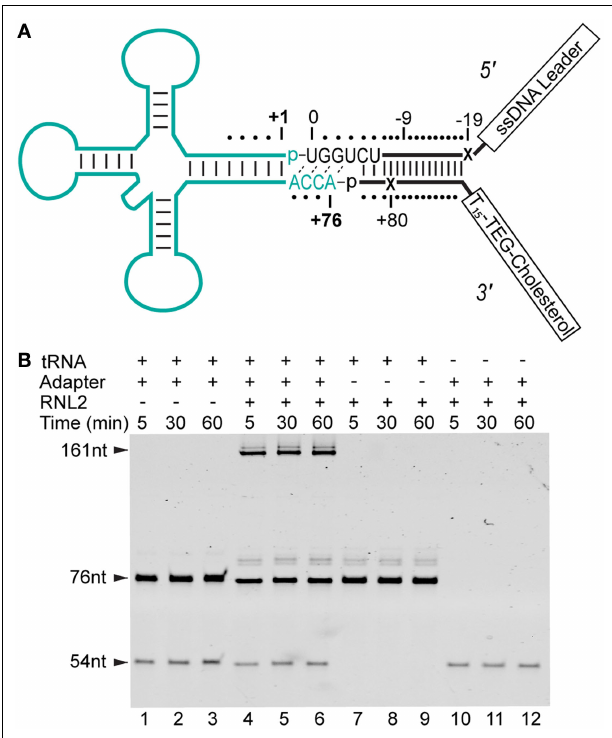
FIGURE 1 | Strategy for constructing adapter-linked tRNA molecules for nanopore experiments . (A) The DNA/RNA chimeric adapter (black lines; RNA nucleotides black letters) was composed of a double stranded region and a four nucleotide RNA overhang (UGGU) ligated to the tRNA (cyan). The adapter specifically targets the conserved CCA tail of deacylated, native tRNA. Phosphodiester bonds formed by enzymatic ligation between the tRNA and the adapter are indicated by dashes between the 3 ′ terminal nucleotide and 5 ′ phosphate (p) at ligation junctions. The boxed tail regions were a single-stranded DNA (ssDNA) leader used for nanopore capture and a poly(dT) region with a terminal TEG-linked (triethylene glycol) cholesterol. This terminal TEG-cholesterol on the 3 ′ adapter strand was designed to localize substrate at the lipid bilayer. Tails are not drawn to scale. The adapter nucleotides are numbered relative to the first and last nucleotide of a canonical tRNA. The X’s indicate abasic positions. (B) Denaturing PAGE analysis of tRNA-adapter ligation reaction (see Materials and Methods). Time points are in minutes. Lanes 1–3, control reaction with S. cerevisiae tRNA Phe (76nt) and adapter (54nt leader strand), but absent RNA Ligase 2 (RNL2). Lanes 4–6, S. cerevisiae tRNA Phe incubated with the adapter and RNL2. Lanes 7–9,